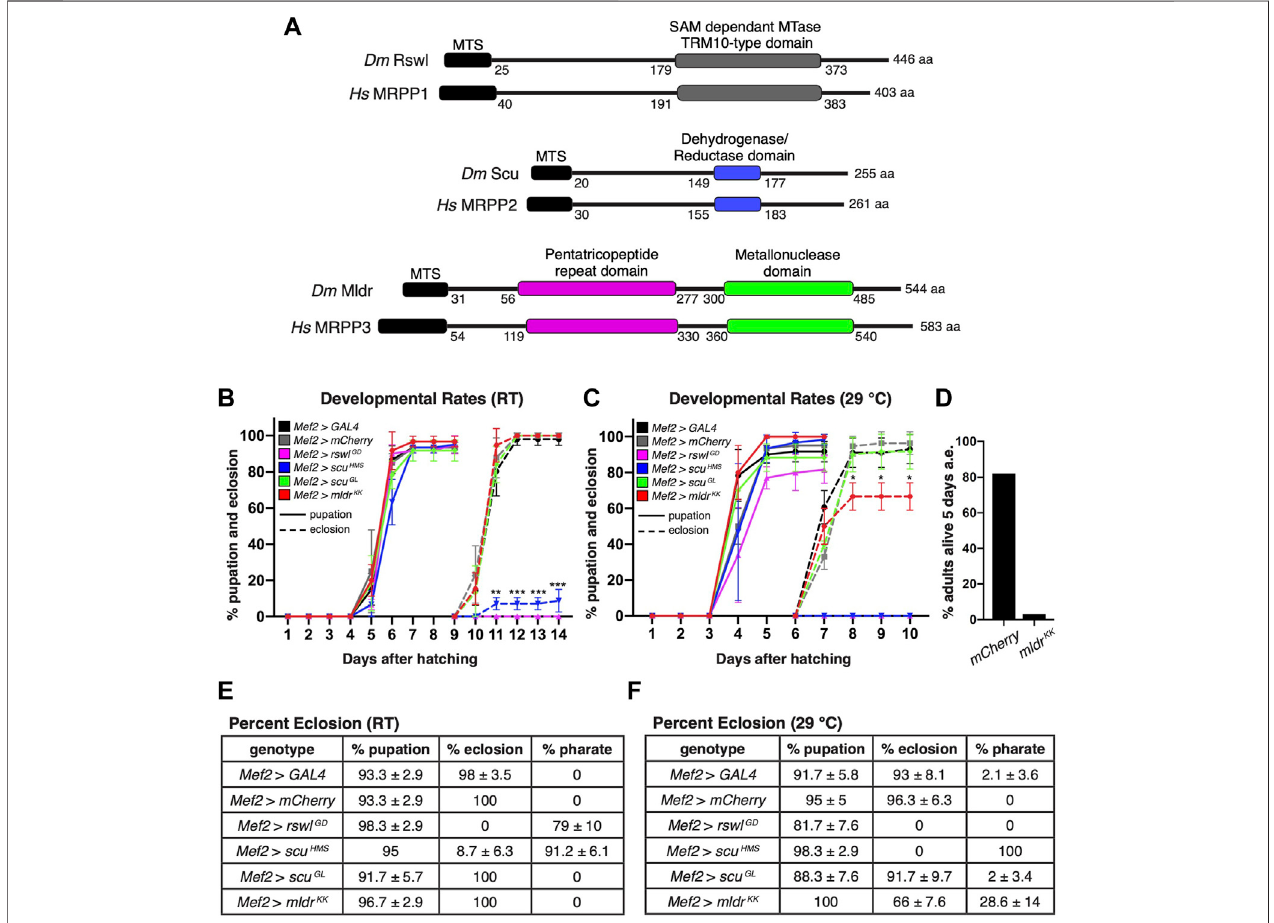
FIGURE 1 | Reduction of mtRNase P subunits in skeletal muscle causes pupation and eclosion defects. (A) Schematic of conserved domains of mtRNase P for Drosophila and humans. MTS = mitochondrial targeting sequence MTase = methyltransferase. (B,C) Pupation (solid lines) and eclosion (dashed lines) rates at room temperature (RT) (B) and29 ° C (C) forlarvaeexpressingmtRNasePRNAi usingthemuscle-speci fi c Mef2 GAL4driver. (D) Percent Mef2 > mldr KK fl iesalive5 days post- eclosion at 29 ° C. Numbers are the aggregate of viable adults from three vials after 5 days and have no error bar. a.e. = after eclosion. (E,F) Percent pupation, eclosion,andpharateadultsatroomtemperature(RT)and29 ° Cafterexpressing mtRNaseP RNAiusing Mef2 GAL4todriveexpression. GAL4 RNAiand mCherry RNAi serve as controls. (B,C) Error bars = s.e.m. Statistical signi fi cance was calculated with GraphPad Prism using one unpaired t-test per time point between GAL4 control RNAiandexperimentalRNAitocalculateindividual p values.Onlytimepointsmarkedwithanasteriskshowadifference.Allovertimepointswerenotstatisticallydifferent from controls. * = p < 0.02, ** = p < 0.001, *** = p < 0.0001. (E,F) ± standard deviation. Graphs were plotted using GraphPad Prism.